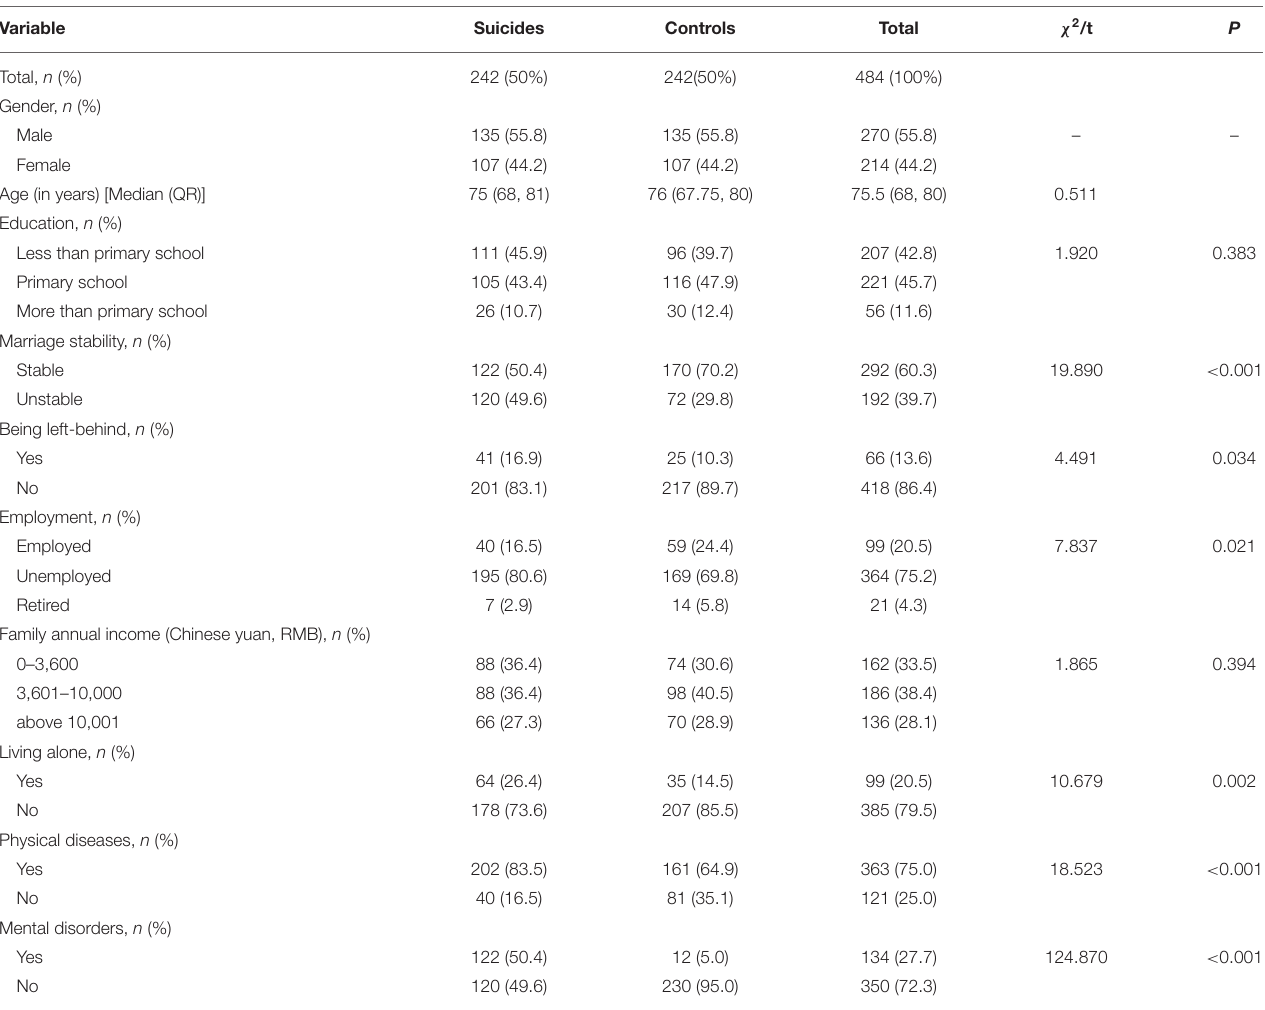
TABLE 1 | Demographic characteristics for the study